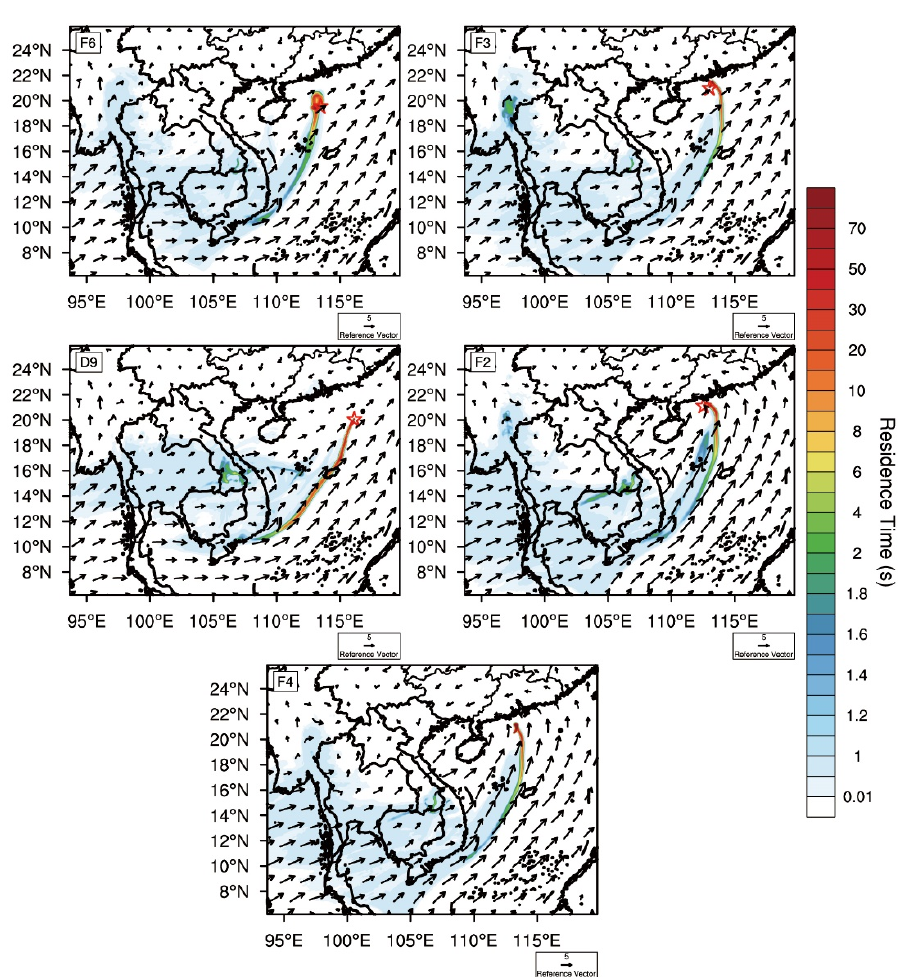
Figure 5. The spatial distribution of residence time (in units of s) of 72 h backward trajectory simulations at monitoring sites F2, F3, F4, F6, and D9. The vector arrow is 72 h surface wind field (in units of m s − 1 ). The red stars denote the position of monitoring sites (receptors).